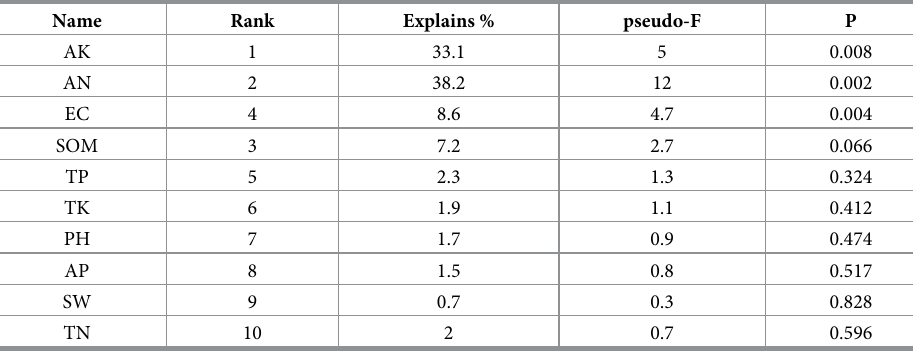
Table 1. Monte Carlo test of the environmental variables and